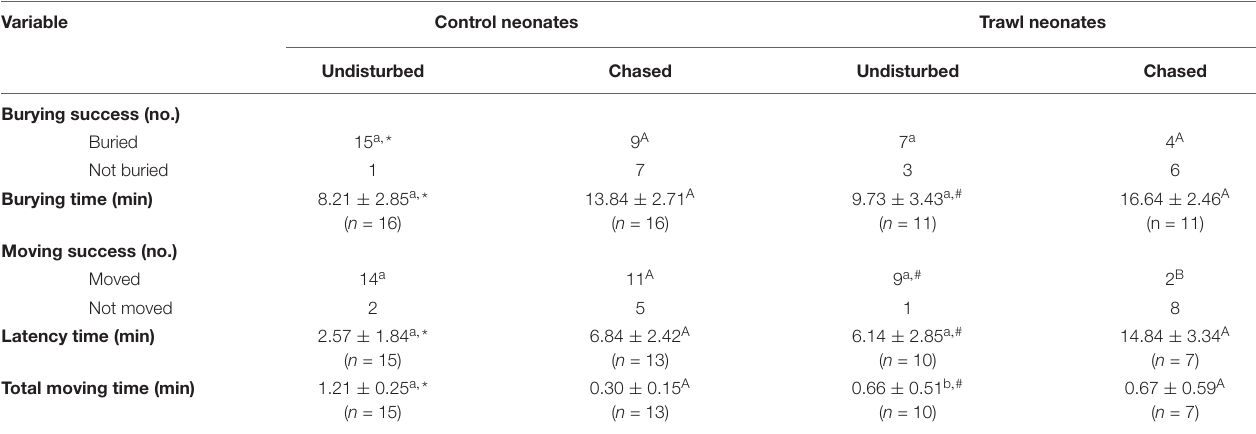
TABLE 3 | Influence of test type (undisturbed or chased) and maternal treatment group (control or trawl) on neonate burying and boldness variables. Variable Control neonates Trawl neonates Undisturbed Chased Undisturbed